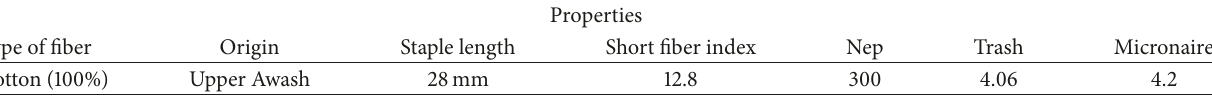
Table 1: Fiber properties.